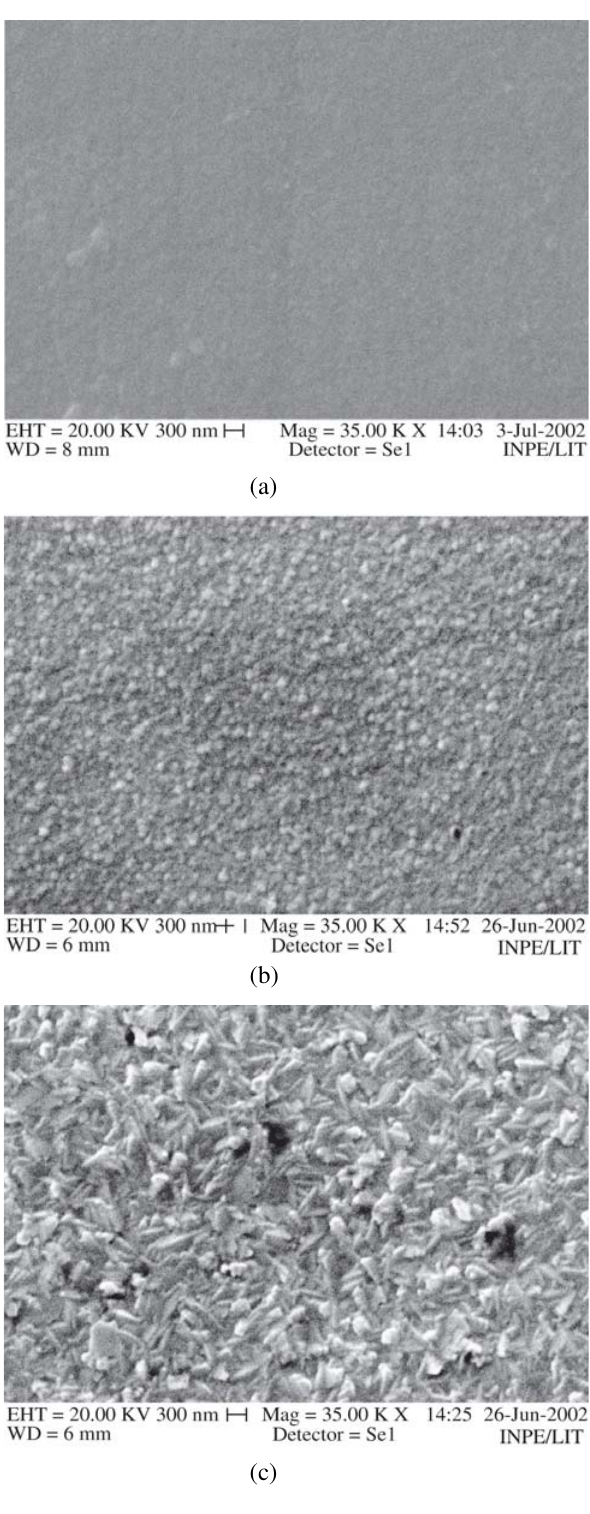
Figure 1. Surface morphology of the nucleation and growth tita- nium films on 304 SS substrates with different deposition